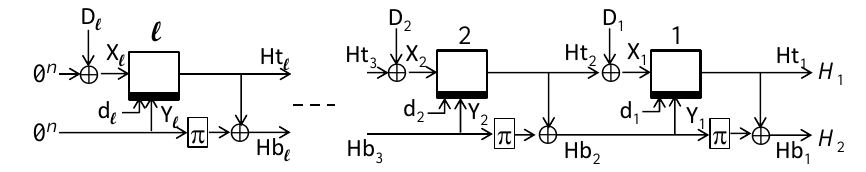
Figure 10: LM-DAE . Hash with indices counted from the last TRP call to the first